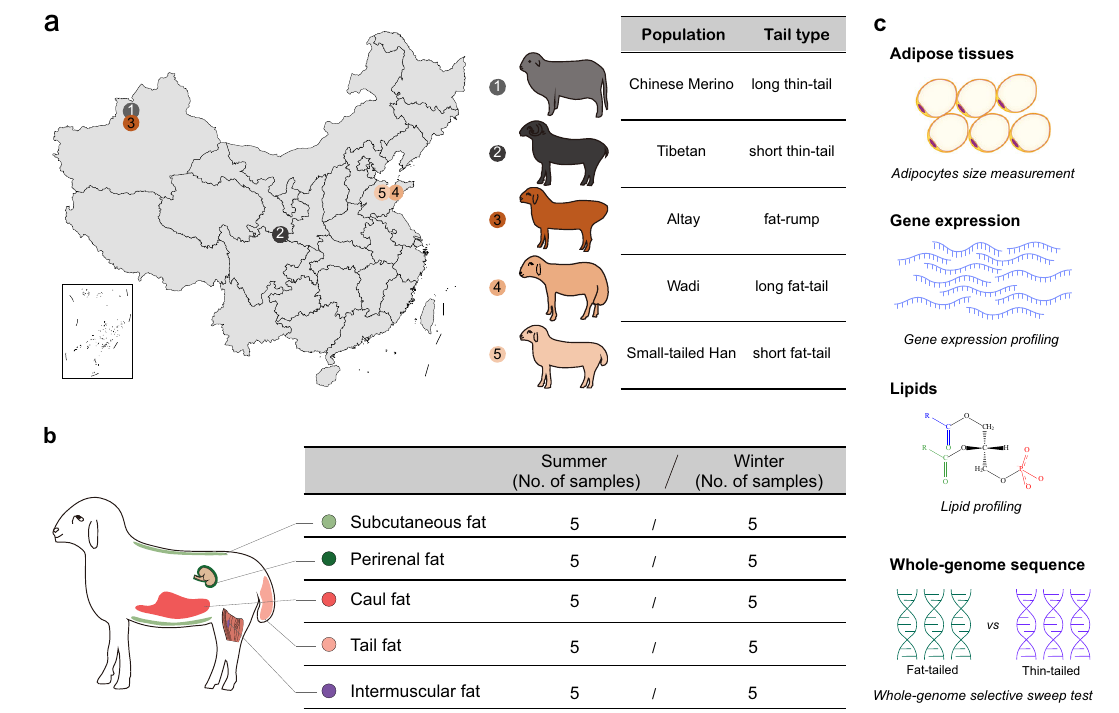
Fig. 1 Schematic overview of the study design. a Sample population information; b Sample tissue information; c Illustration of the data types used in the study. Histological analysis was used to measure adipocyte size; gene expression and lipid pro fi les were quanti fi ed by transcriptomic and lipidomic analyses; and whole-genome sequence data was used to identify candidate genome regions and genes under